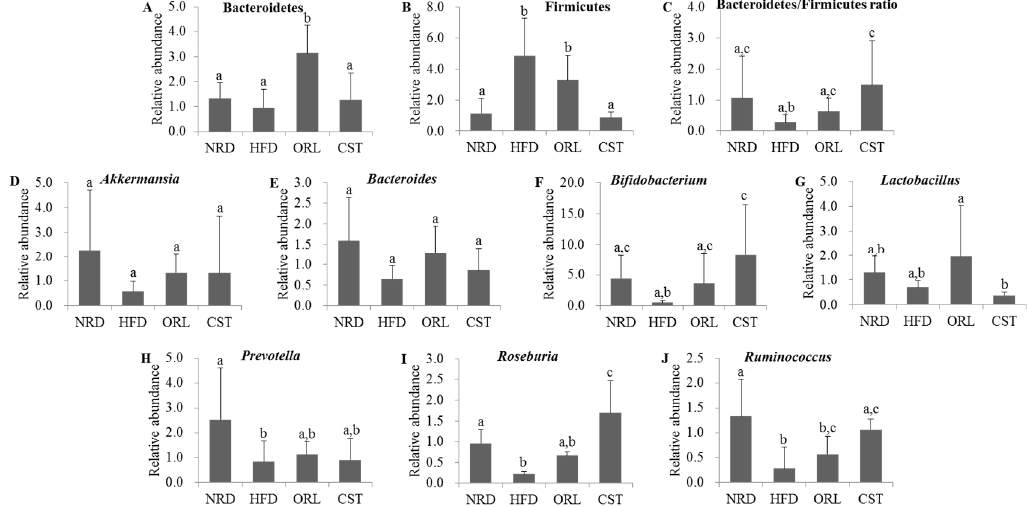
Figure 5. Relative abundance of related microbes in mice fecal samples: ( A – C ) The relative abundance of phyla; and ( D – J ) the relative abundance of genus of microbiota in the stool samples of mice as reflected by microbial 16sRNA gene expression. The results are expressed as normalized fold values relative to the normal group. Data represented as mean ± SD ( n = 5). Different letters above bars indicate significant difference from each other at p < 0.05 as determined by one-way ANOVA with Least Significant Difference (LSD) post hoc test.